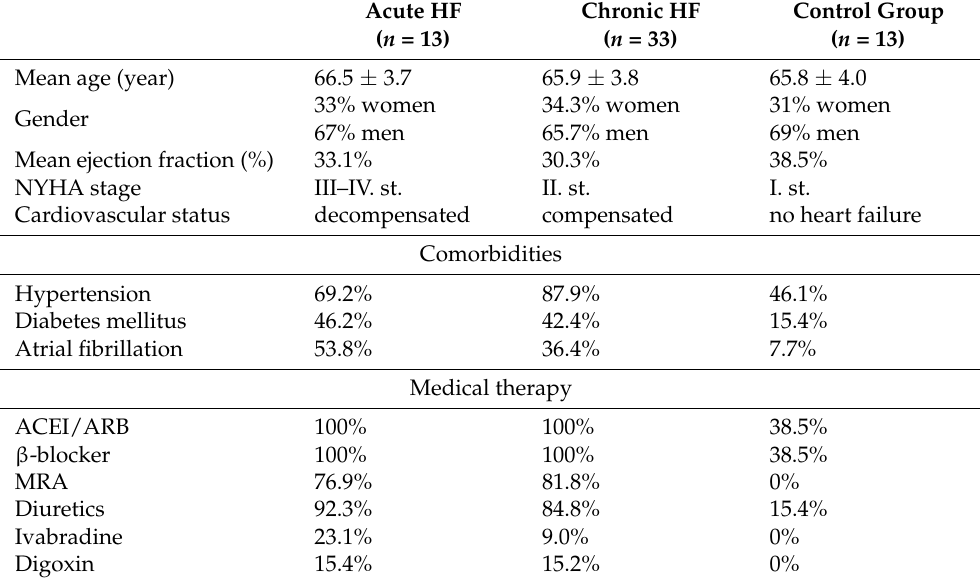
Table 1. The most important demographic and clinical parameters of the examined patients with acute, chronic heart failure (HF) and the control group. NYHA: New York Heart Association Classifi- cation, ACEI: angiotensin-converting enzyme inhibitor, ARB: angiotensin-II receptor blocker, MRA: mineralocorticoid receptor